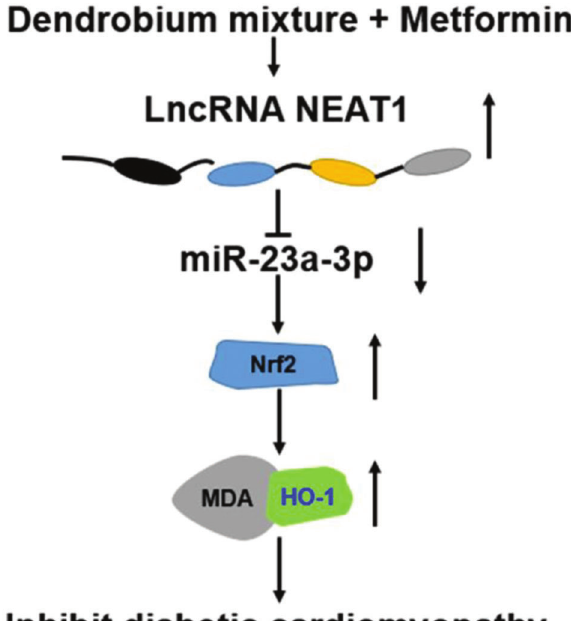
Figure 7 - Proposed mechanism of action for the combination of dendrobium mixture and metformin in the treatment of diabetic cardiomyopathy. NEAT1 , acting as a sponge of miR-23a-3p , can regulate the expression of MDA and HO-1 by targeting Nrf2